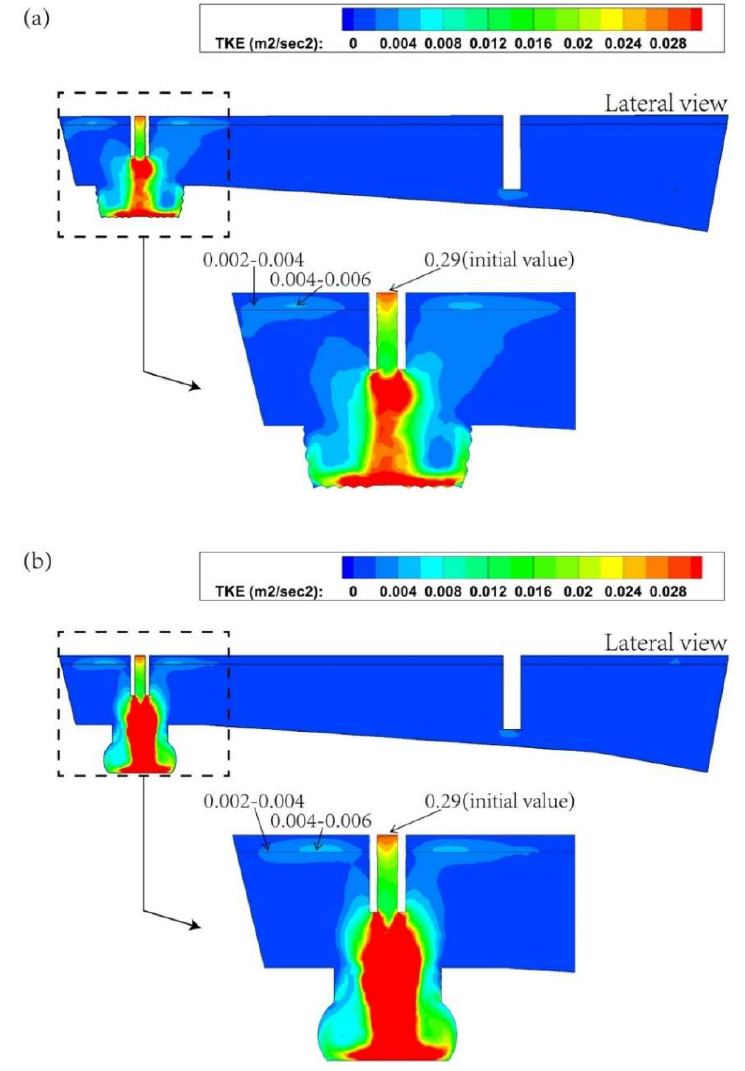
Figure 7. Turbulence distribution of ( a ) case 1 and ( b ) case 2 at 850 s.